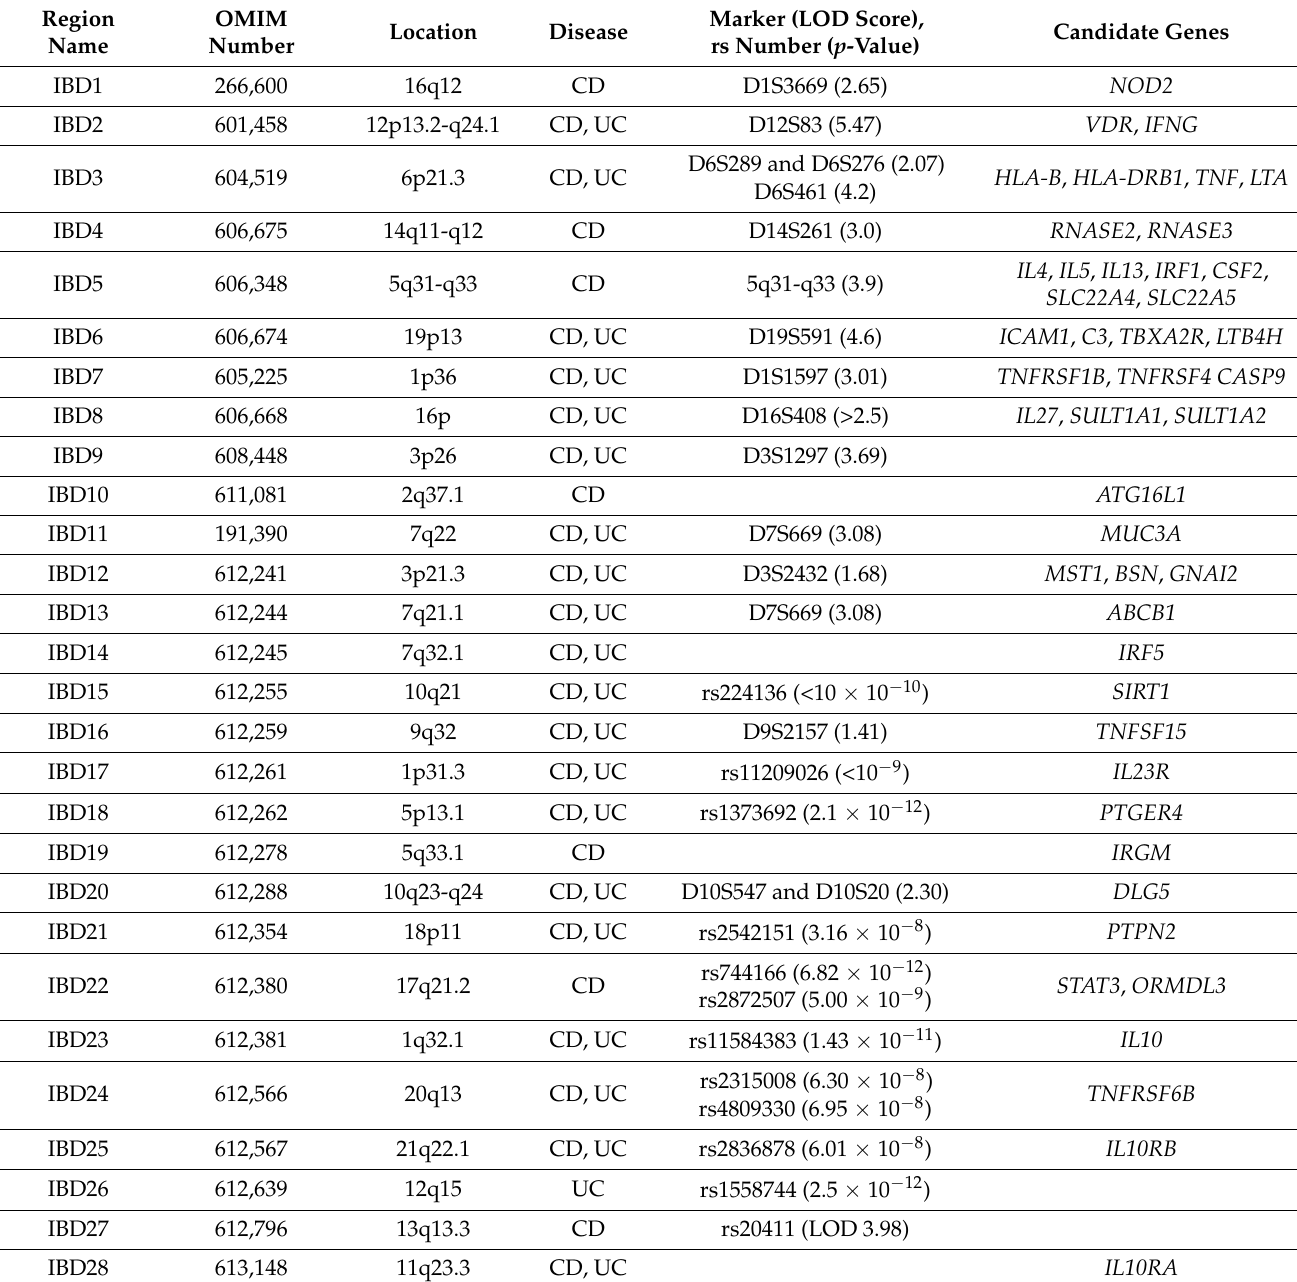
Table 1. IBD chromosome regions and main candidate